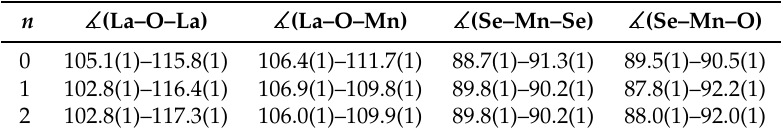
Table 3. Selected bond angles ( ◦ ) of mC -La 2 MnSe 2 O 2 ( n = 0), La 4 MnSe 3 O 4 ( n = 1) and La 6 MnSe 4 O 6 ( n =